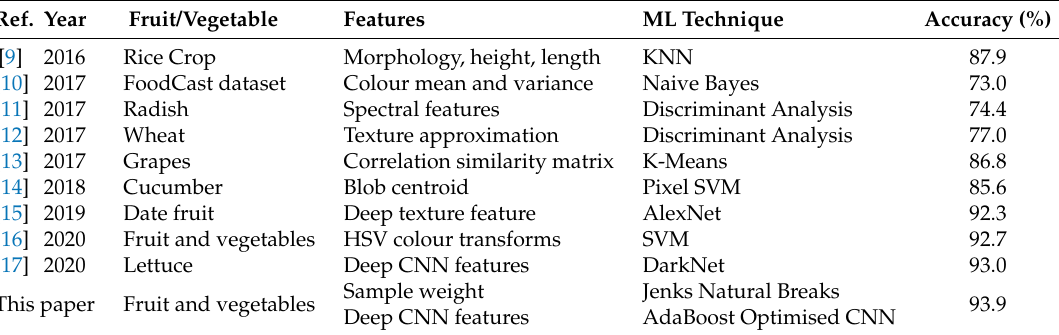
Table 1. Comparison of recent state-of-the-art features and Machine Learning (ML) techniques for fruit and vegetable